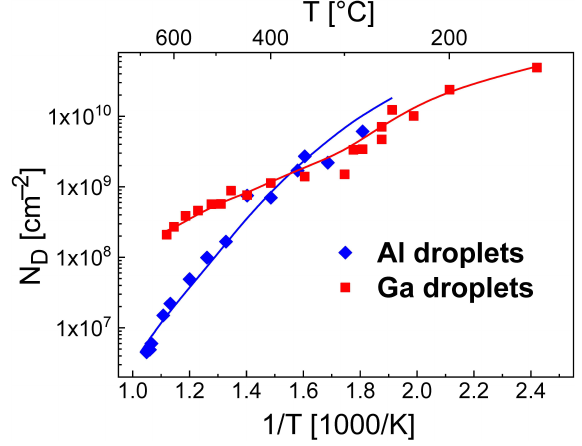
Figure 1. Density N D of Al and Ga droplets as function of temperature T . The experimental data (symbols) are taken from AFM images [34,35]. The lines are calculated using the rate model with E S = 0.19 eV, E E = 1.71 eV for Al droplets and E S = 0.115 eV, E E = T -dependent (see text) for Ga